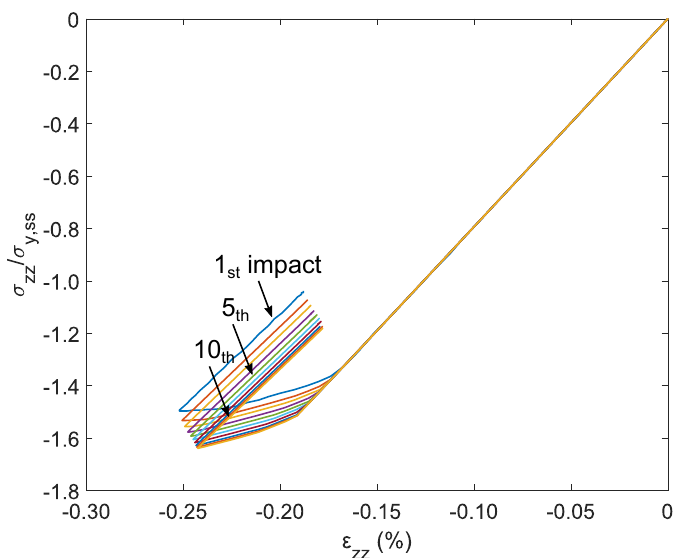
Figure 9. Normalized normal stress at z -direction with respect to the normal strain at the trailing edge of the foil profile at fixed end, considering ten multiple impacts [29].